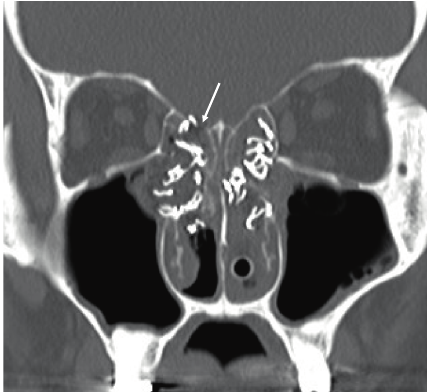
Figure 1: The head and neck computed tomography (CT) radiological findings. The head and neck coronal CTin the bone window setting revealed a defect in the cribriform plate (arrow), consistent with a cerebrospinal fluid leak.